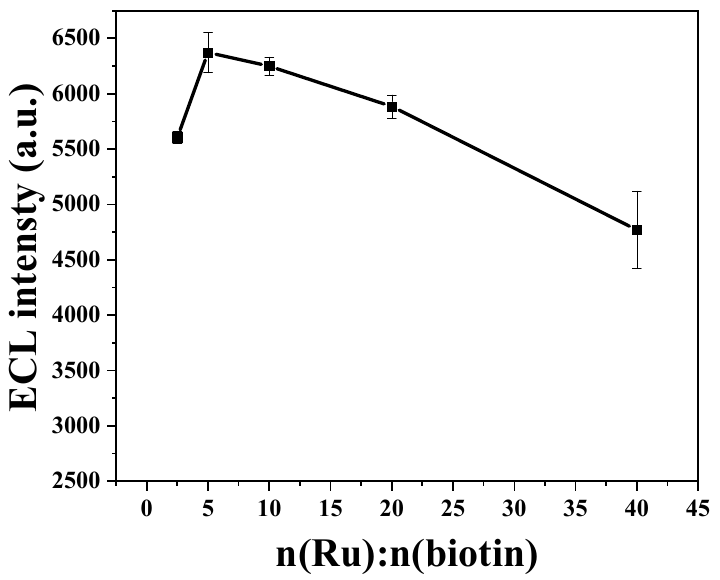
Figure 1. ECL intensity variation curves of magnetic complexes formed by different ratios of Ru(bpy) 32+ and biotin-labeled phage displaying affibodies and streptavidin-coated magnetic microspheres.